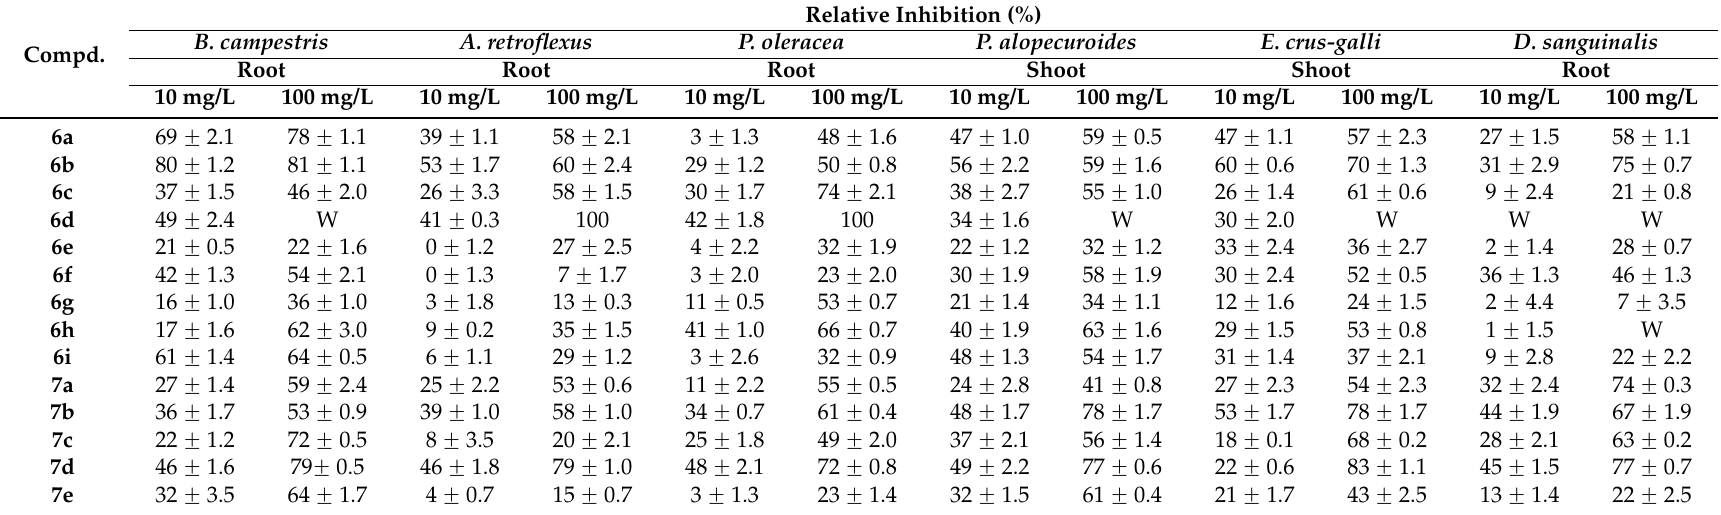
Table 2. Inhibition of target compounds on the growth of